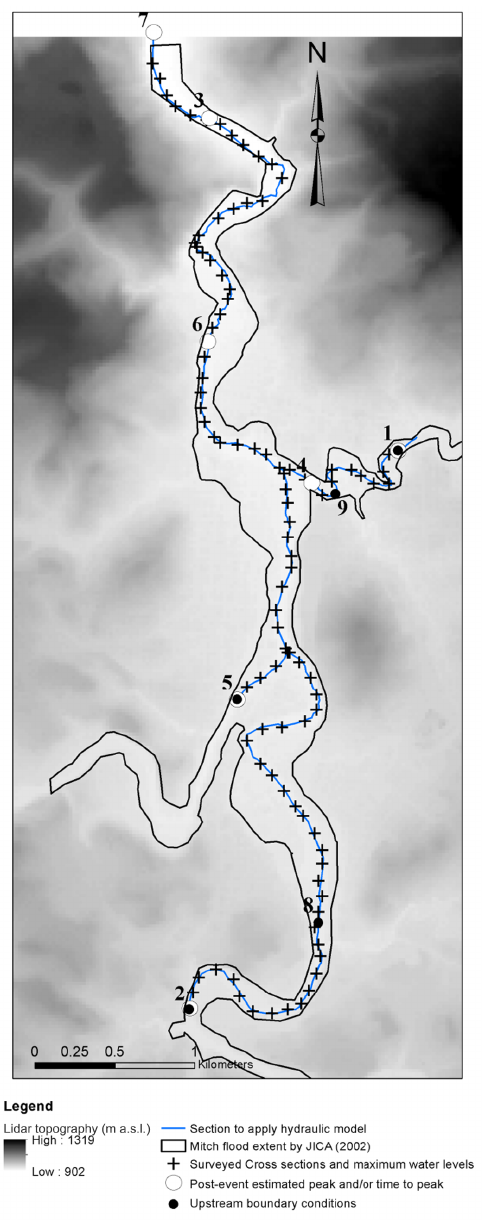
Figure 2. Geometry set-up for hydraulic simulation at the Teguci- galpa floodplain. Lidar data from Mastin (2002).